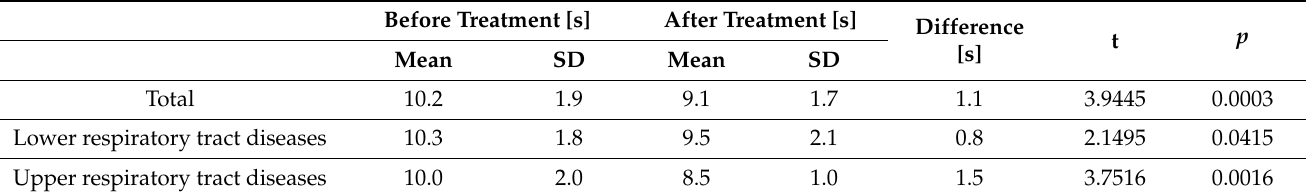
Table 2. FSST execution time before and after a pulmonary rehabilitation programme combined with endurance and strength training in the underground environment.